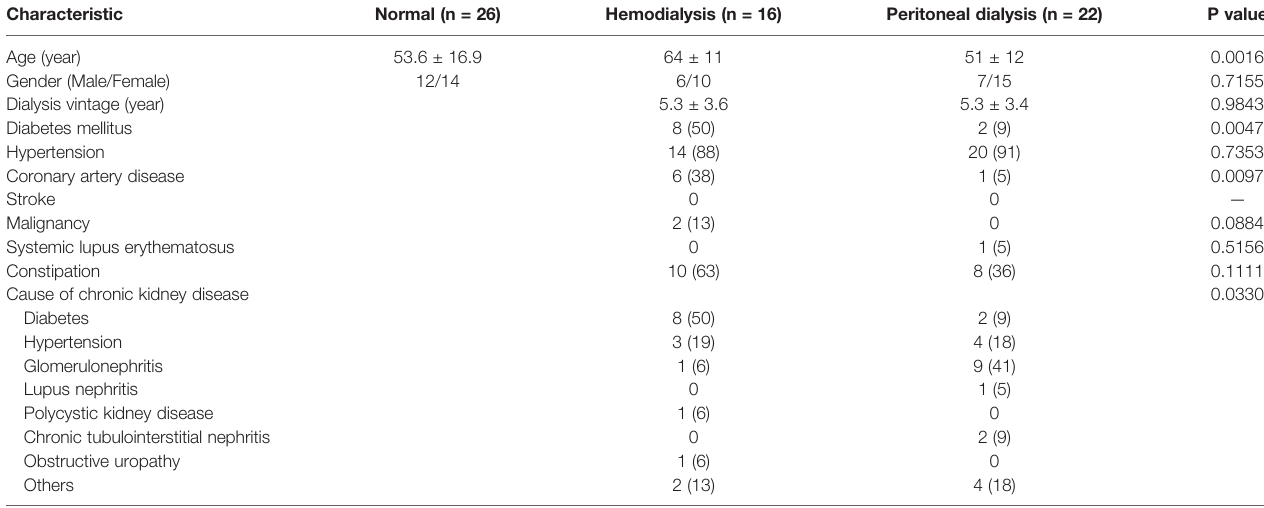
TABLE 2 | Anthropometric and demographic data of the dialysis patients and healthy controls. Characteristic